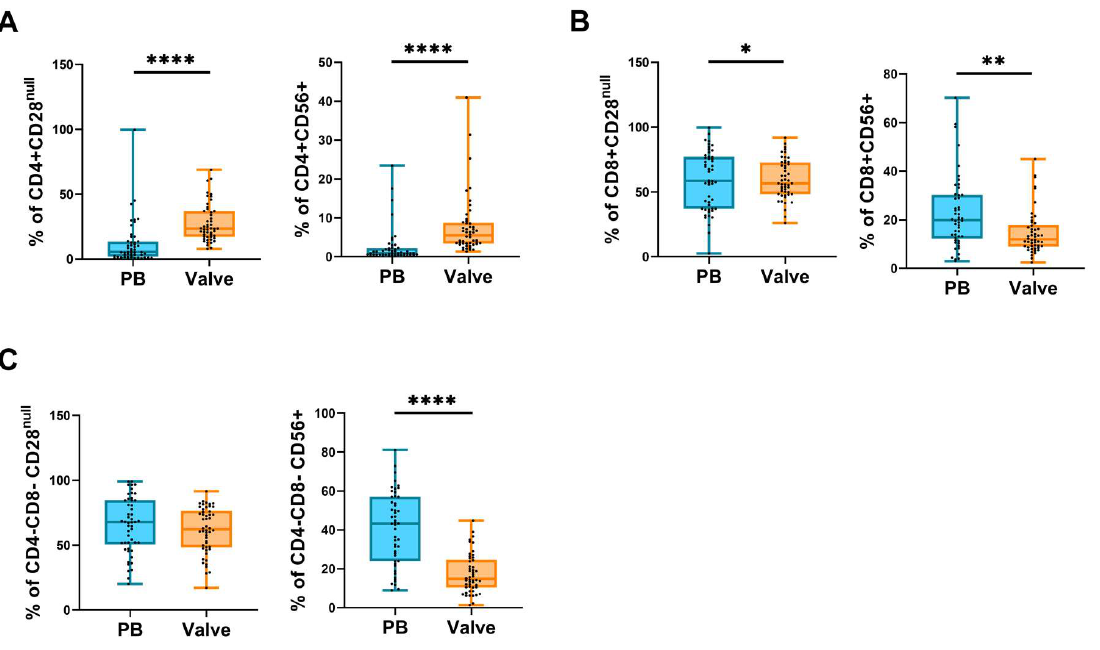
Figure 3. Expression of CD28 and CD56 in T cells. Boxplot graphs showing the phenotype of ( A ) CD4+, ( B ) CD8+, and ( C ) CD4 − CD8 − T cells from peripheral blood (blue) and valvular infiltrate (orange). The horizontal bar shows the median and whiskers show the maximum and minimum values. Each dot represents a donor. The significance of the data was determined by the Mann–Whitney comparison test. * p < 0.05, ** p < 0.01, and **** p <0.0001.